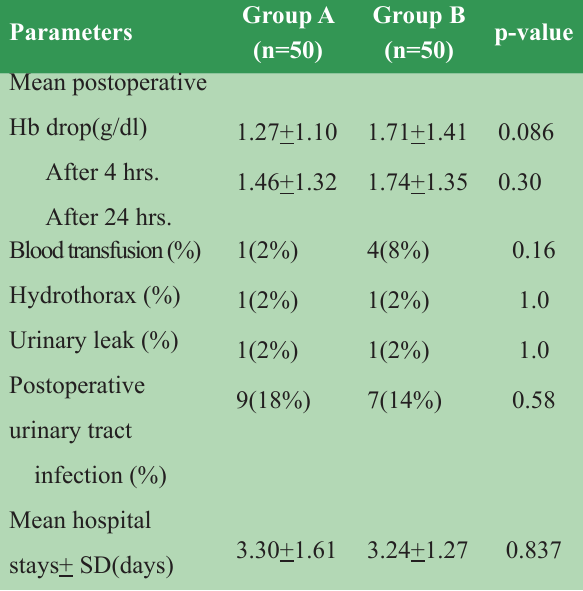
Table 3. Postoperative values and outcome of procedure